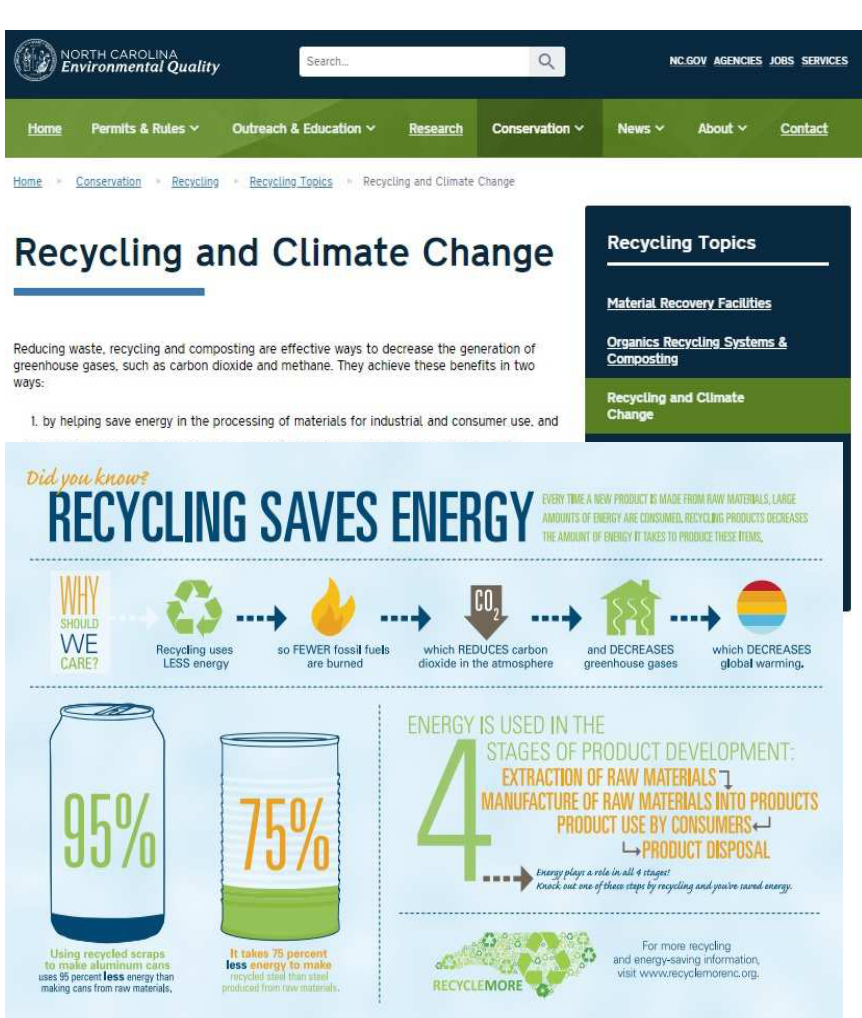
Figure 5. Official website of North Carolina Government: North Carolina department